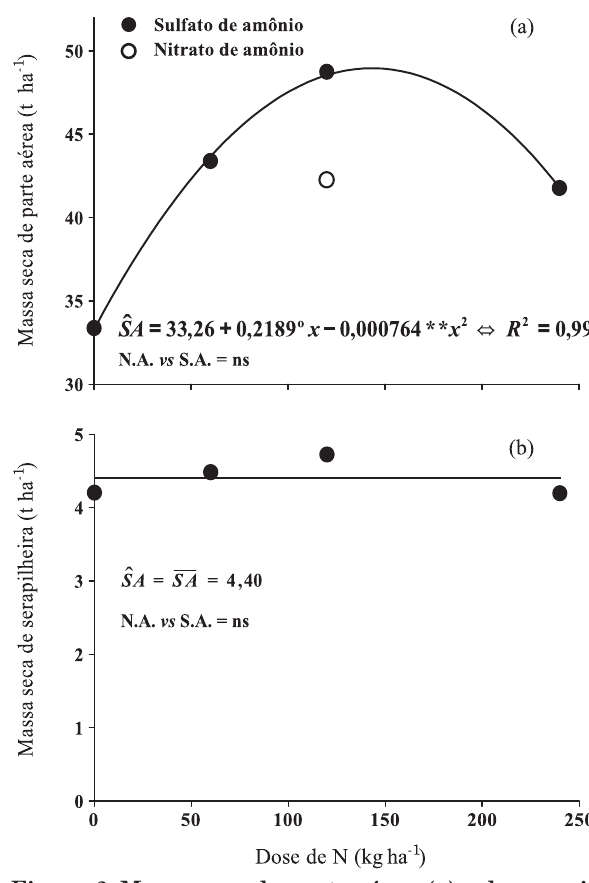
Figura 2. Massa seca da parte aérea (a) e da serapi- lheira (b) de um plantio do clone aec1528 ® de eucalipto aos 30 meses de idade sob doses de n aplicado como sulfato de amônio (s.a.) e por nitrato de amônio (n.a.) na dose de 120 kg ha -1 . º, **, ns: significativo a 10 e 1 % e não signifi- cativo até 10 %, respectivamente, pelo teste F. Quadro 4. equações relacionando os teores foliares de macronutrientes (g kg -1 ) e de